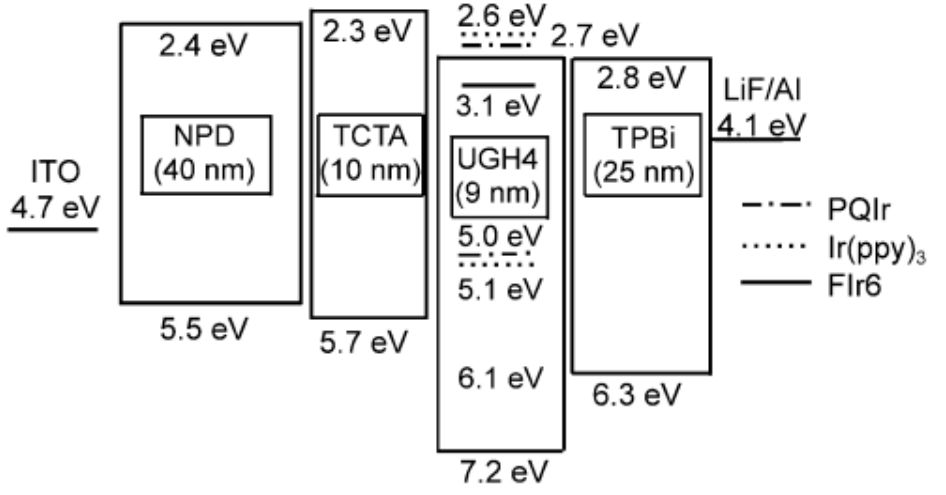
Figure 6. Structure of the WOLED and the proposed energy level. NPD is 4,4 ′ -bis[ N -(1-naphthyl)- N - phenyl-amino]biphenyl. Reproduced from Reference [124]. phenyl-amino]biphenyl. Reproduced from Reference